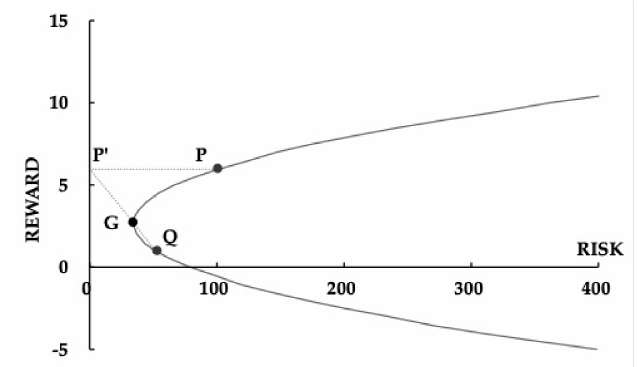
Figure 2. The geometric relationship of orthogonal